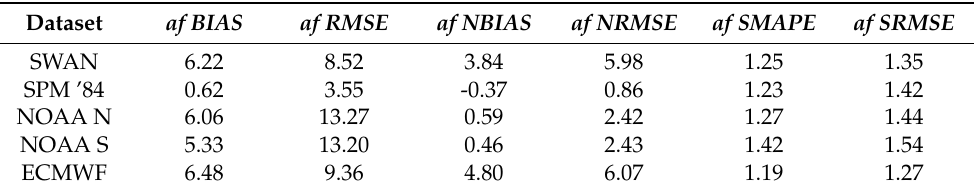
Table 5. Wave model errors’ statistical